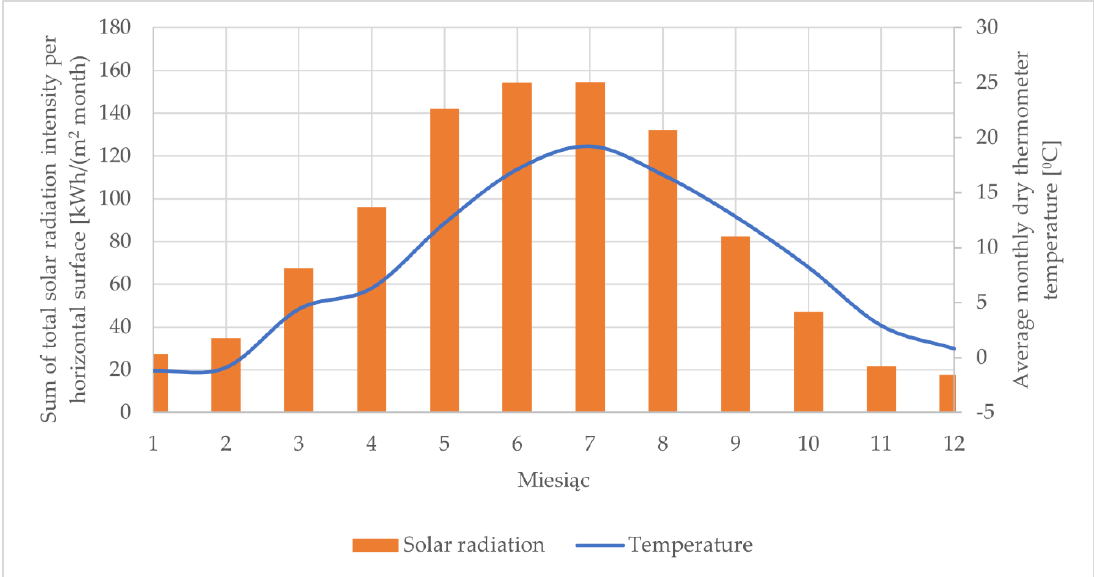
Figure 4. Meteorological data for the Warsaw-Ok˛ecie measuring station compiled on the basis of 30 full measurement